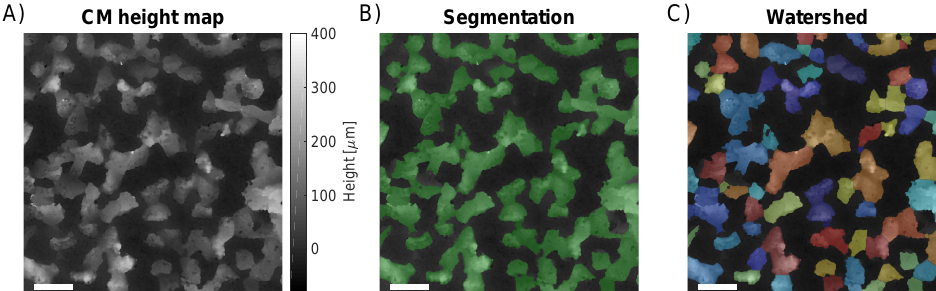
Figure 4. Illustration of the image segmentation of P80 sandpaper. ( A ) The topographic map after filtering to remove low-frequency variations. ( B ) The segmentation result after the adaptive thresholding is shown in green overlaid on the topographic map. ( C ) The coloring shows the labeling of the individual particles after applying the modified watershed algorithm to the segmentation. The width of the scale bar is 0.5